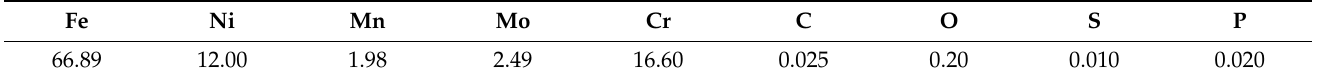
Table 6. Chemical composition of porous 316 stainless steel, wt %.